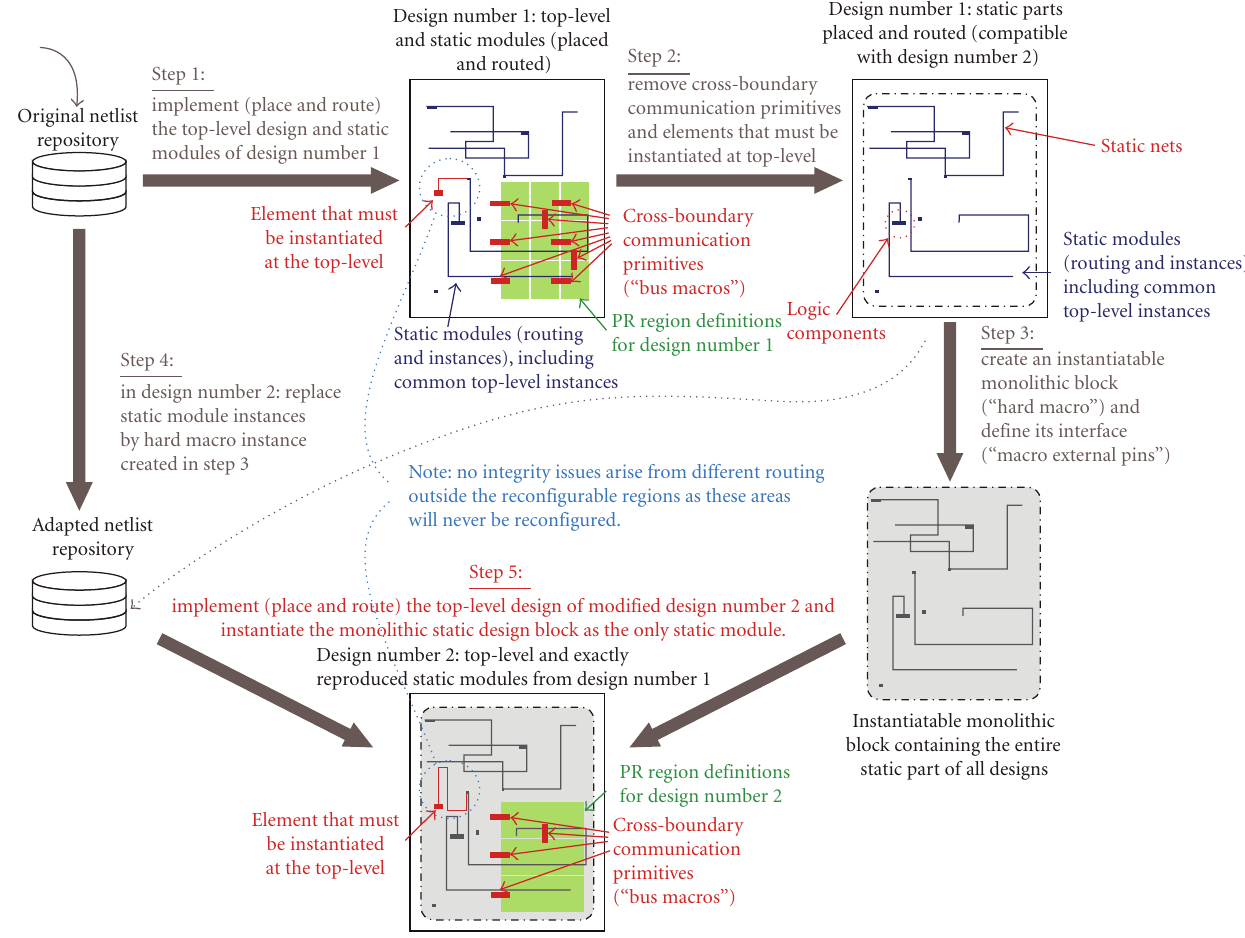
Figure 2: Exact cross-project reproduction of static design artifacts within PR